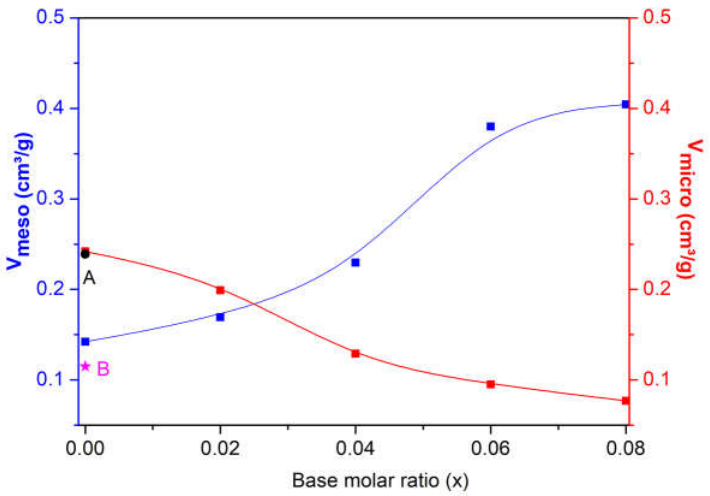
Figure 9. Zeolite mesopore and micropore volumes as a function of the base ratio (x) used for the modification. A and B represent the volume of micropores and mesopores in the original USY zeolite, respectively.